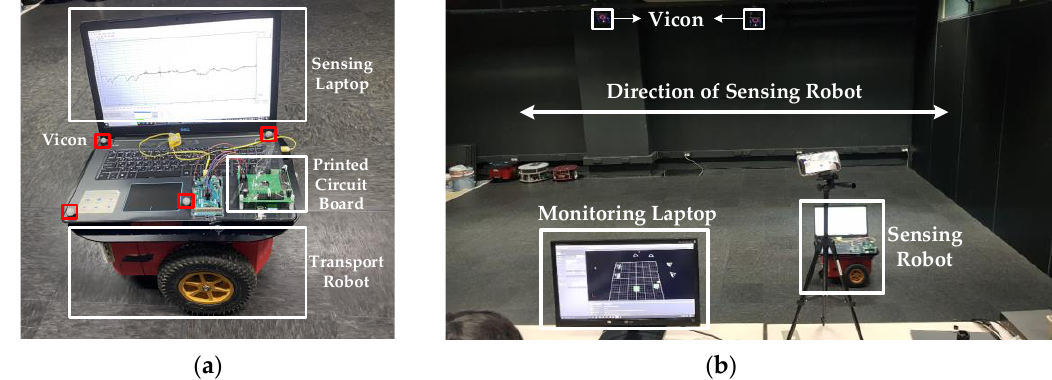
Figure 17. ( a ) Photograph of sensing robot for measuring air flow; ( b ) photograph of measurement environment. The velocity measurement with digital code output of the proposed air flow sensor is shown in Figure 18. Measurements of the digital codes were performed by a 12-bit SAR ADC in the range of 0–4096. When the velocities of the sensing robot were 0 m/s, 0.5 m/s, and 1 m/s, the digital codes were 2751, 2467, and 2270, respectively. These results show that the proposed air flow sensor properly detects the air velocity. The sensitivity of the proposed readout IC was 481 LSB/(m/s).